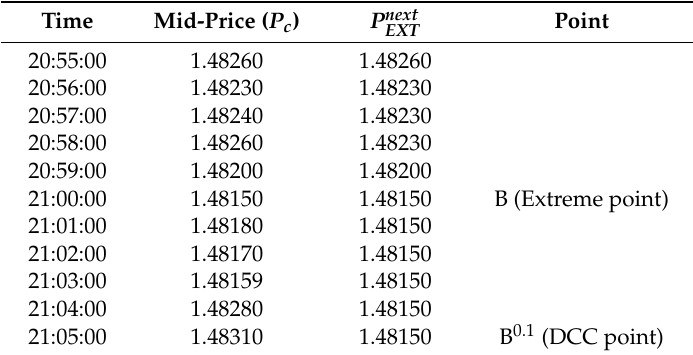
Figure 1. The black line indicates GBP/CHF mid-prices sampled minute by minute from 1 January 2013 19:05:00 to 1 February 2013 02:05:00 (UK). The red line exemplifies what a DC downtrend looks like. Table 1. The progress of the value of P next during the period from 20:55:00 and 21:05:00. According to Figure 1 this period refers to a downtrend. In such a case, P next refer to the lowest price observed so far during this downtrend.